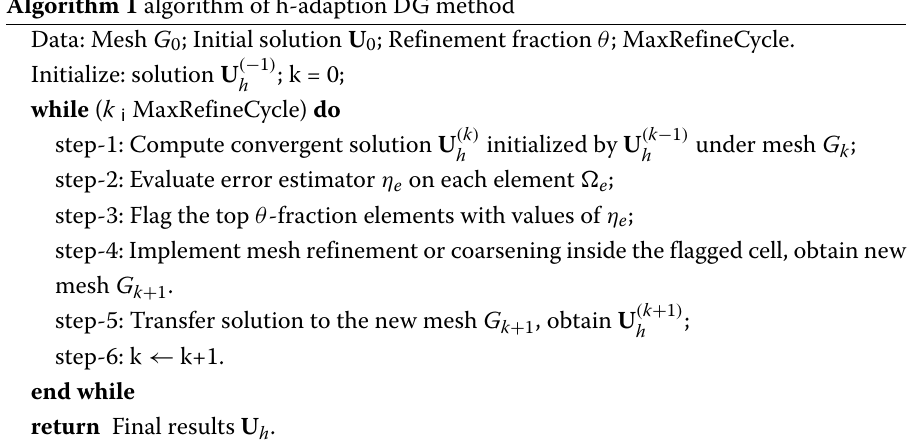
Algorithm 1 algorithm of h-adaption DG